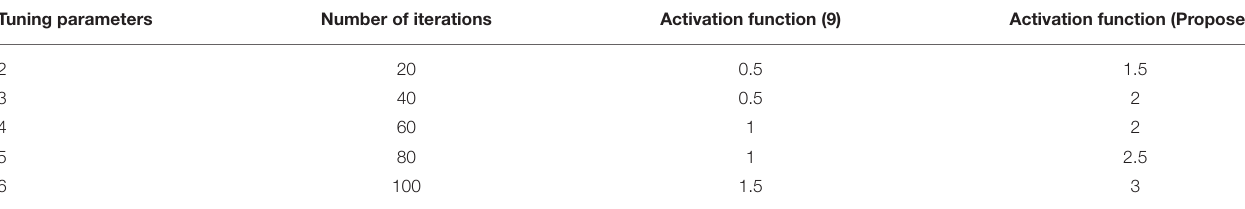
TABLE 4 | Iteration and activation